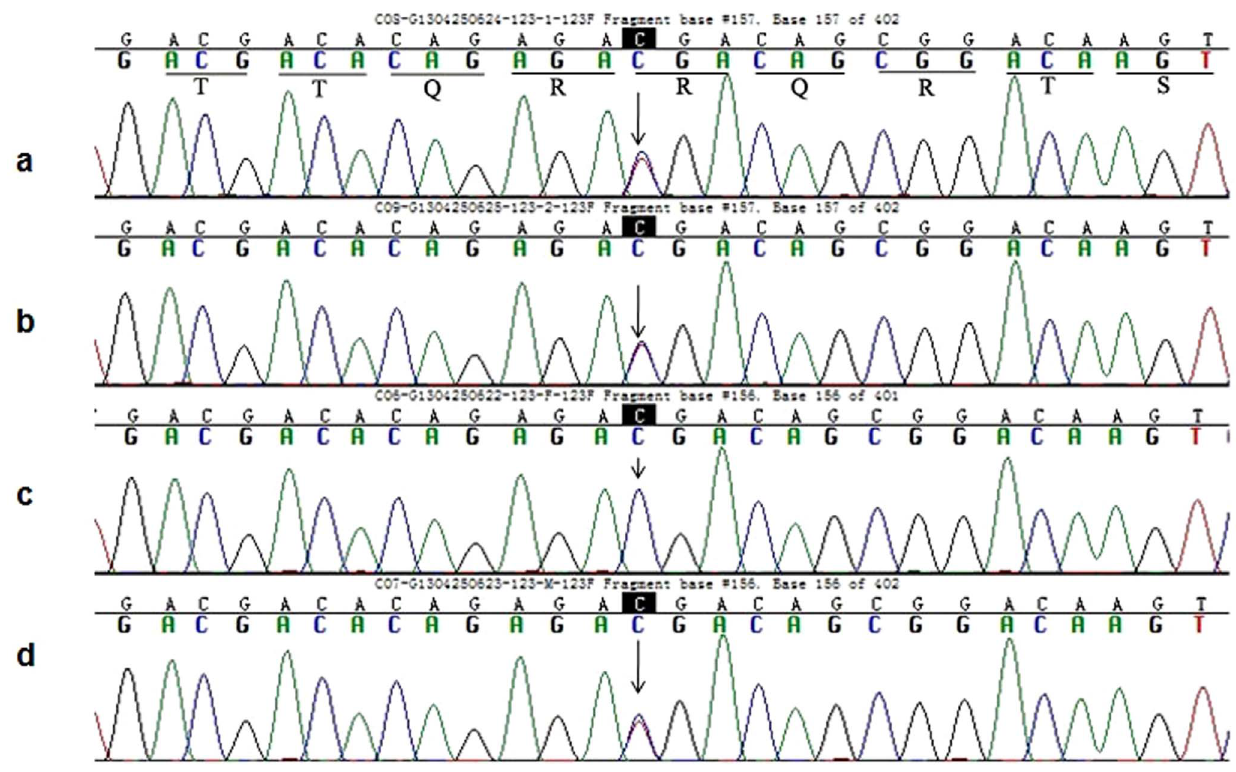
Figure 1. Partial sequence of exon 23 in the PKHD1 from member of this Caroli disease-affected pedigree. (a), (b) and (d) Arrowhead indicates the heterozygous C and T at nucleotide 2341 in proband, elder twins and their mother respectively. (c) Arrowhead indicates the C at nucleotide 2341(wild type) in their father.